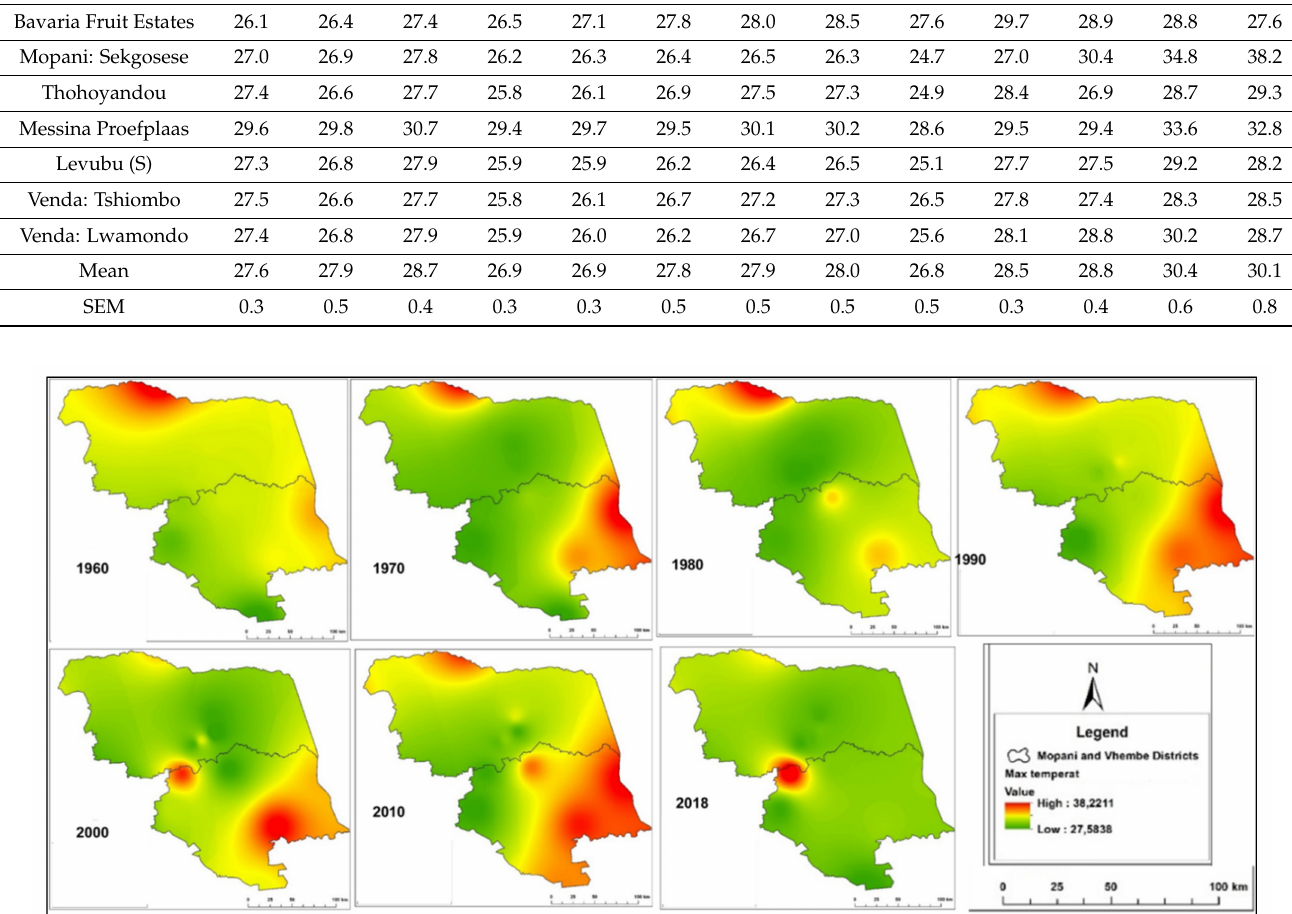
Figure 5. Maximum temperature for 1960, 1970, 1980, 1990, 2000, 2010, and 2018 in the Mopani and Vhembe Districts. Table 6. Statistical regression analysis for maximum temperature in the Mopani and Vhembe districts. R 2 = N = 944